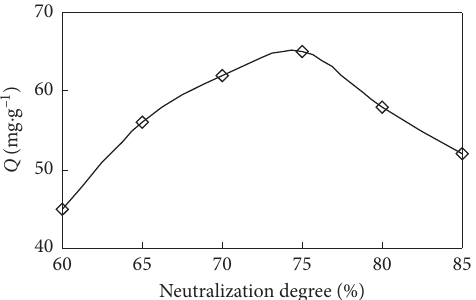
Figure 3: Effects of the crosslinking agent on Cu 2+ absorption capability.